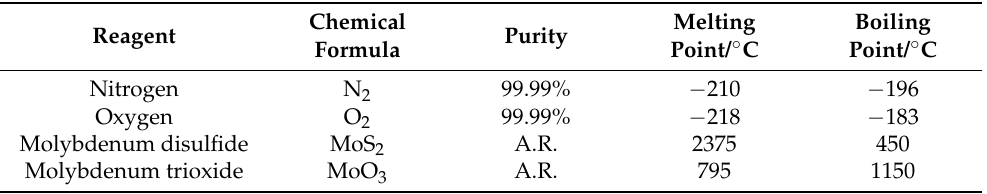
Figure 12. The images of molybdenum oxide and molybdenum disulfide.